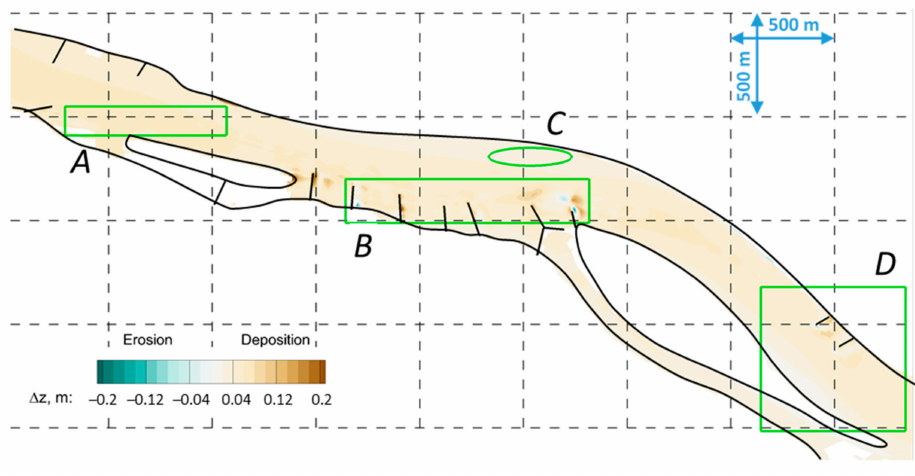
Figure 10. Calculated bed changes by the W& C formula for the historical flood wave (Figure 3).